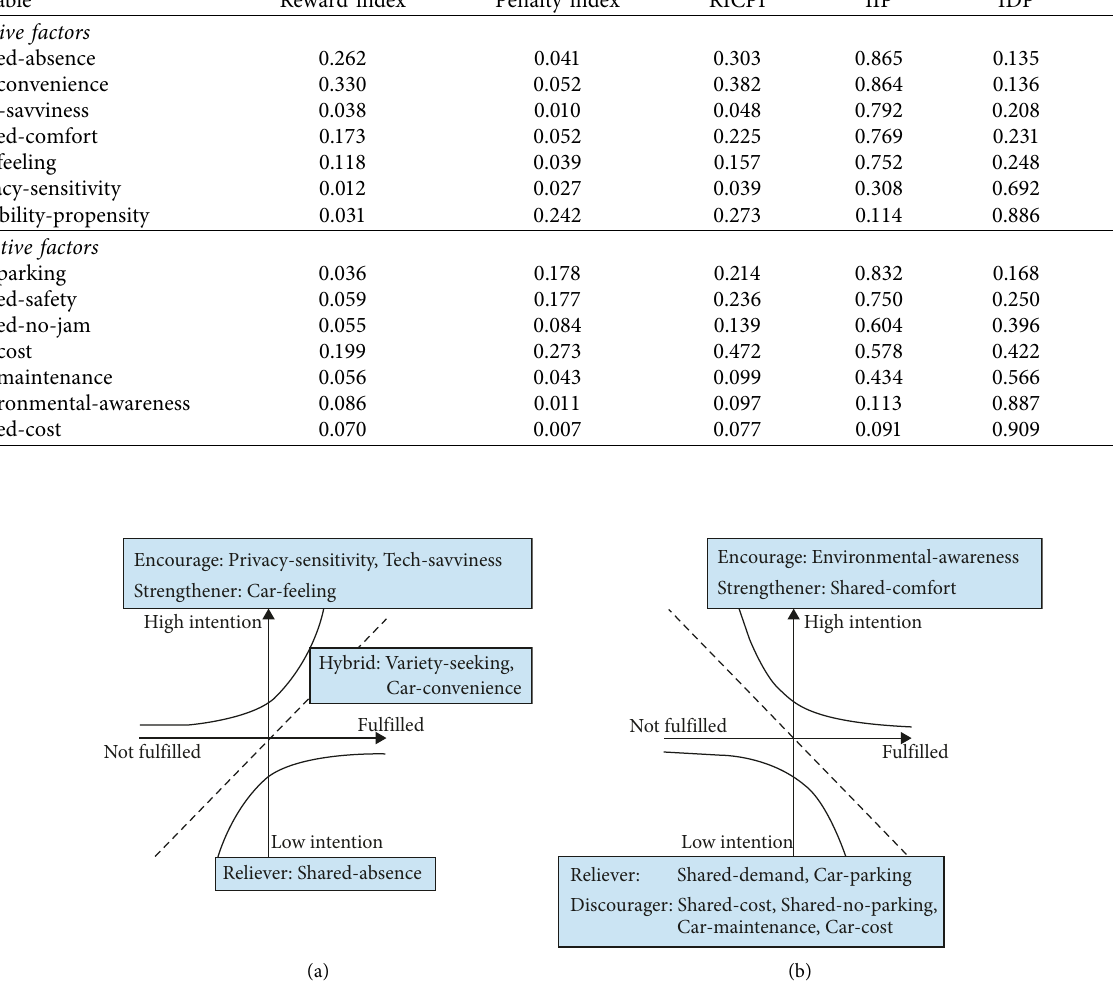
Figure 5: The asymmetric factor structure of the pre-COVID-19 car purchase intention. (a) Positive correlations. (b) Negative